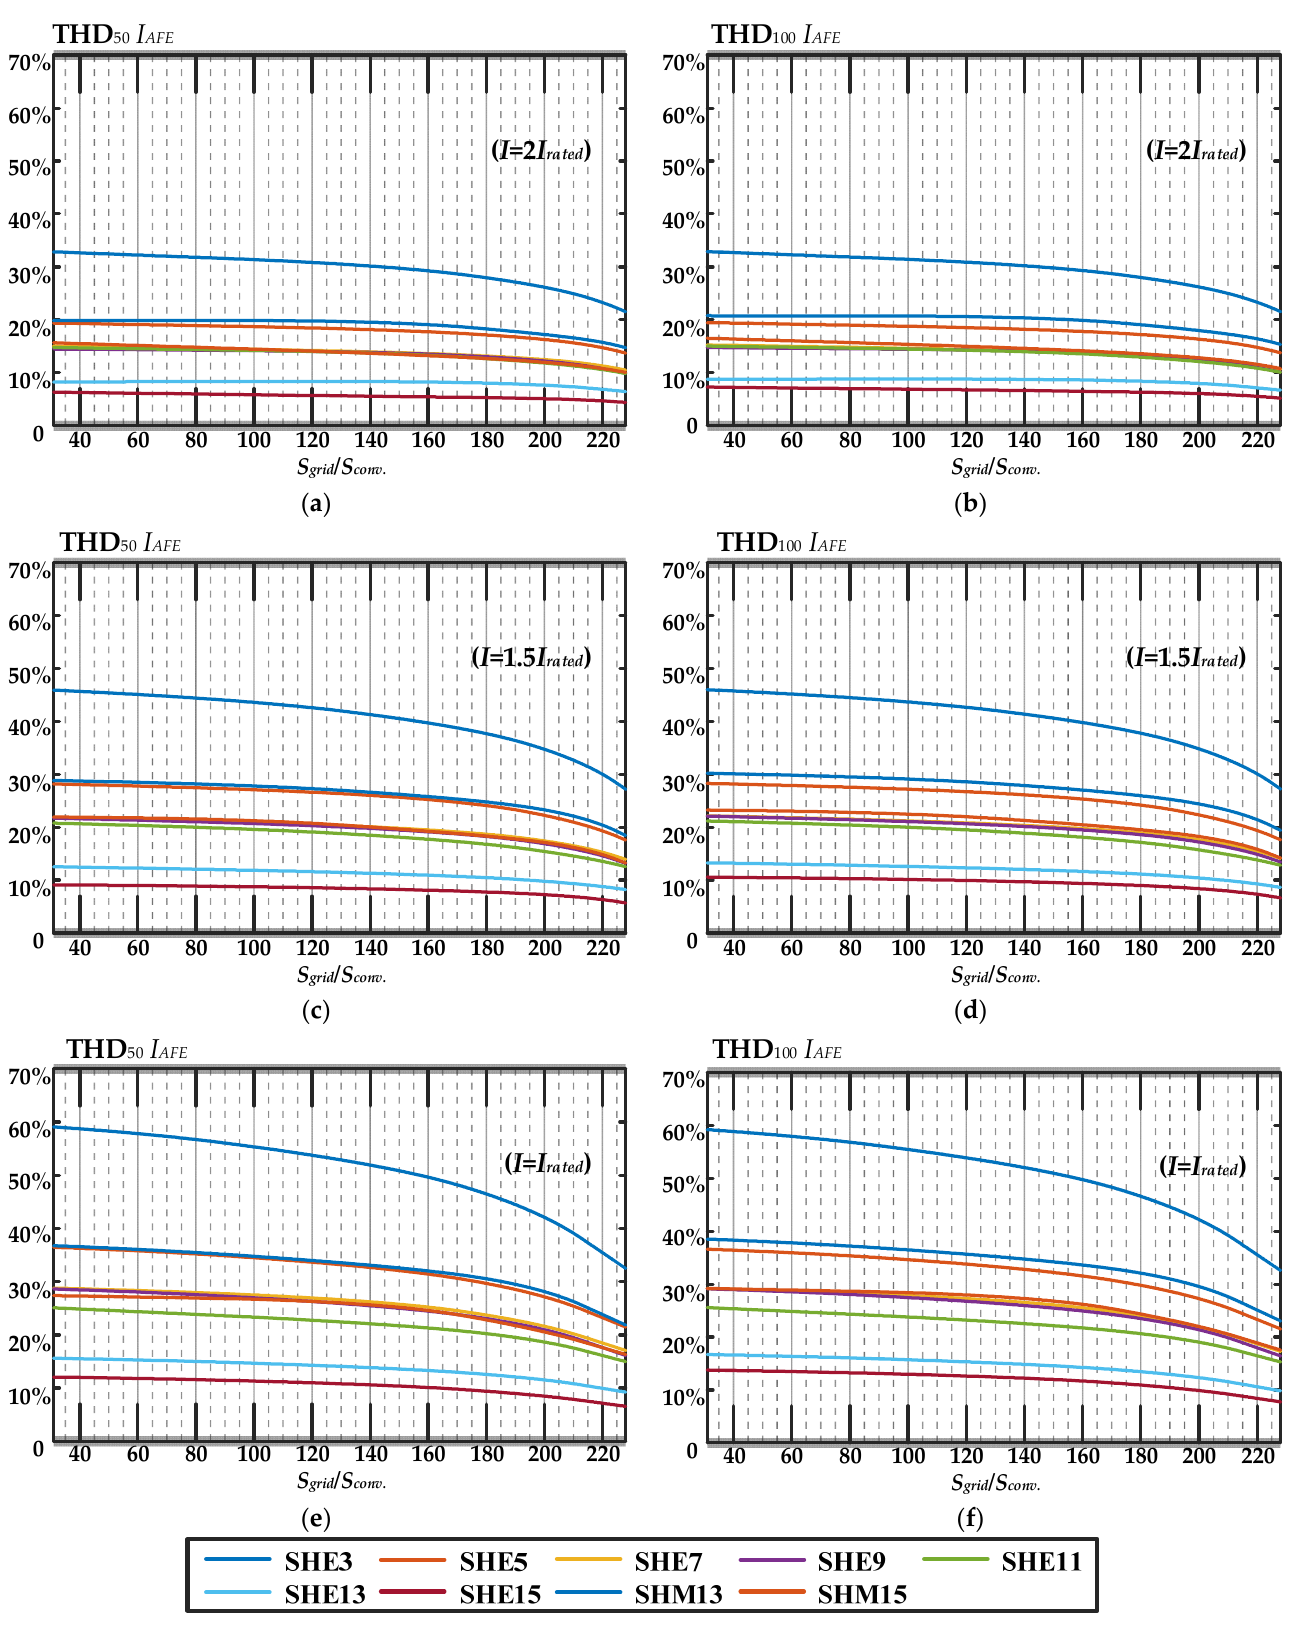
Figure 10. THD comparisons of I AFE between the harmonics up to the 50th order ( a – c ) and up to the 100th order ( d – f ).